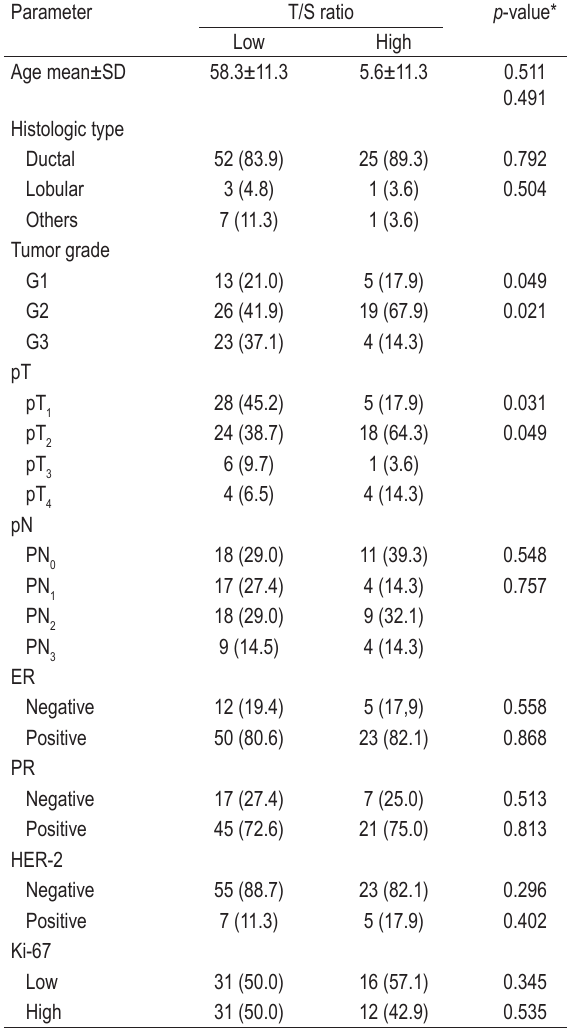
TABLE 6. Correlation between TSR and clinicopathological parameters Parameter T/S